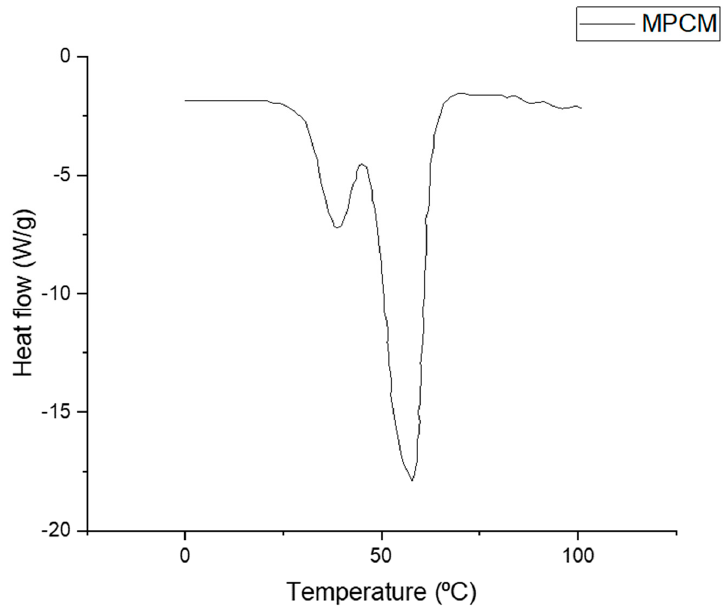
Figure 4. DSC thermogram of an optimized batch.